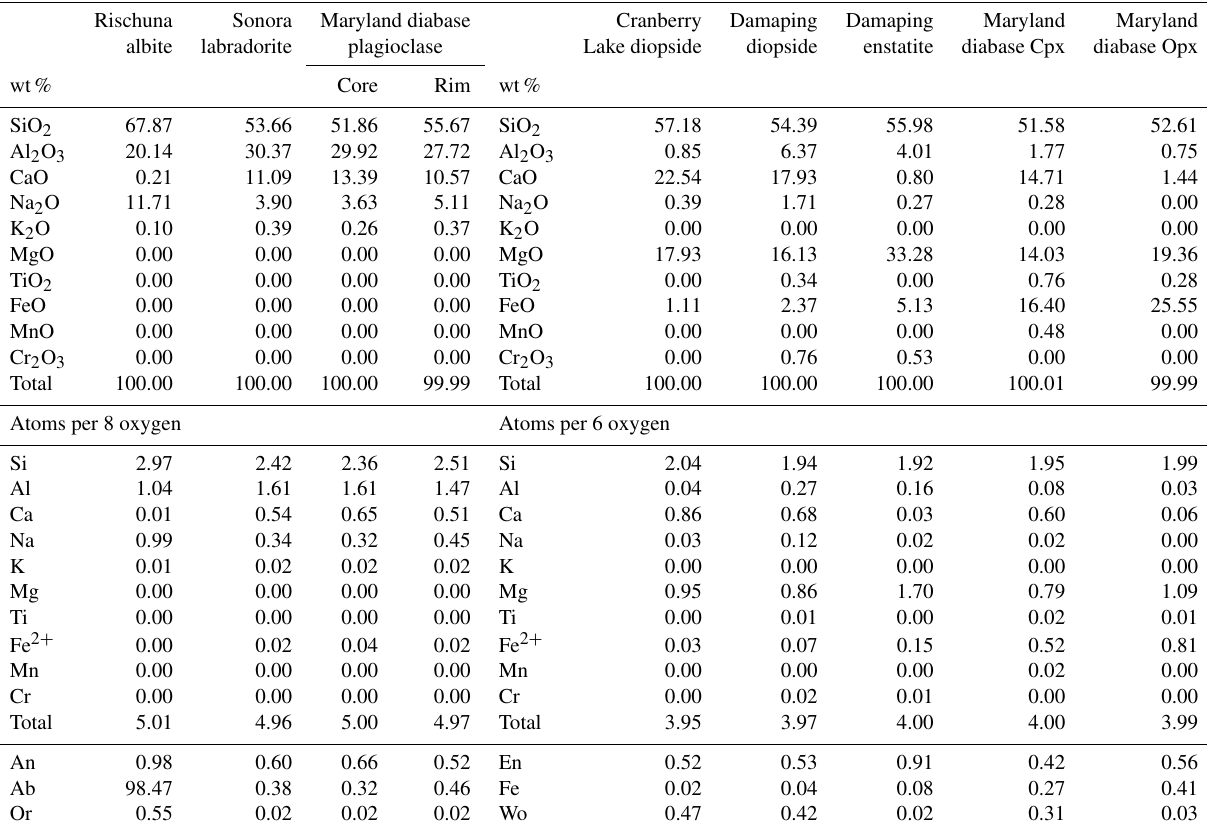
Table 1. Mineral composition. Representative mineral measurements as normalized oxide wt% and as calculated stoichiometric mineral composition for the different starting materials. All Fe is taken as Fe 2 + due to the reducing environment in the sample assembly.